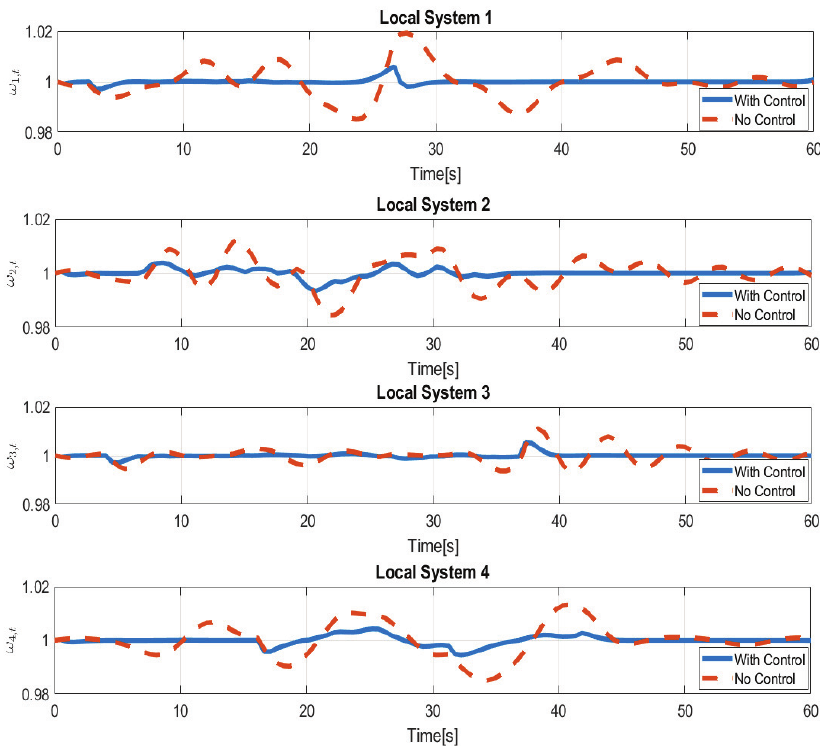
Energies 2020 , 13 , x FOR PEER REVIEW Figure 7. Frequency optimal results at each local system. Figure 7. Frequency optimal results at each local system.